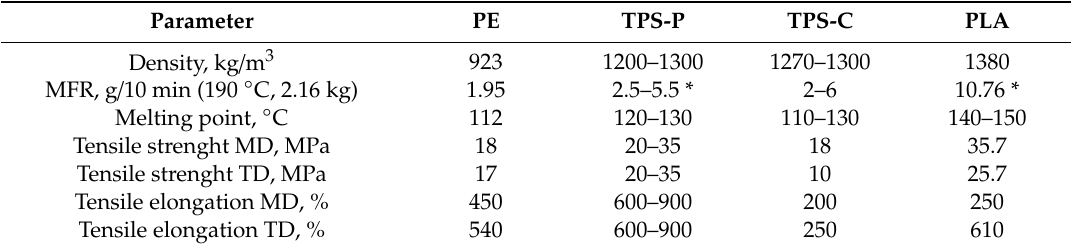
Table 1. Comparison of selected properties of tested materials and foils made of them according to manufacturers’ data